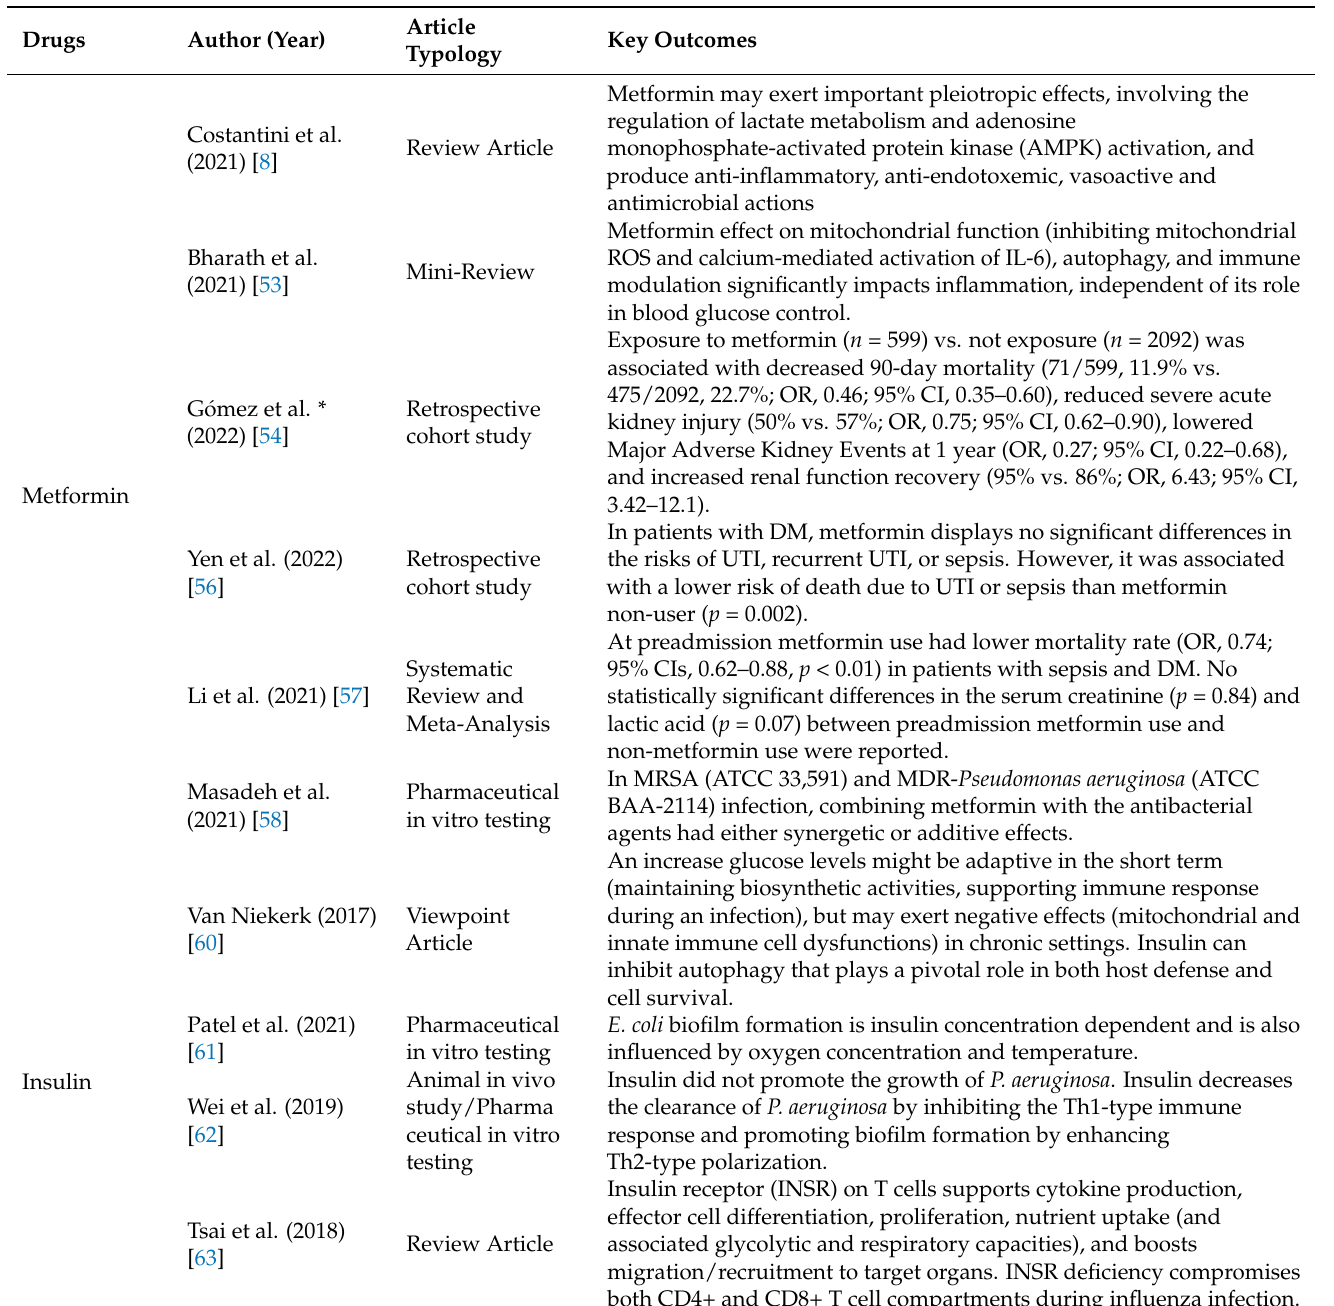
Table 1. Effects of anti-diabetic medications on immune modulation and